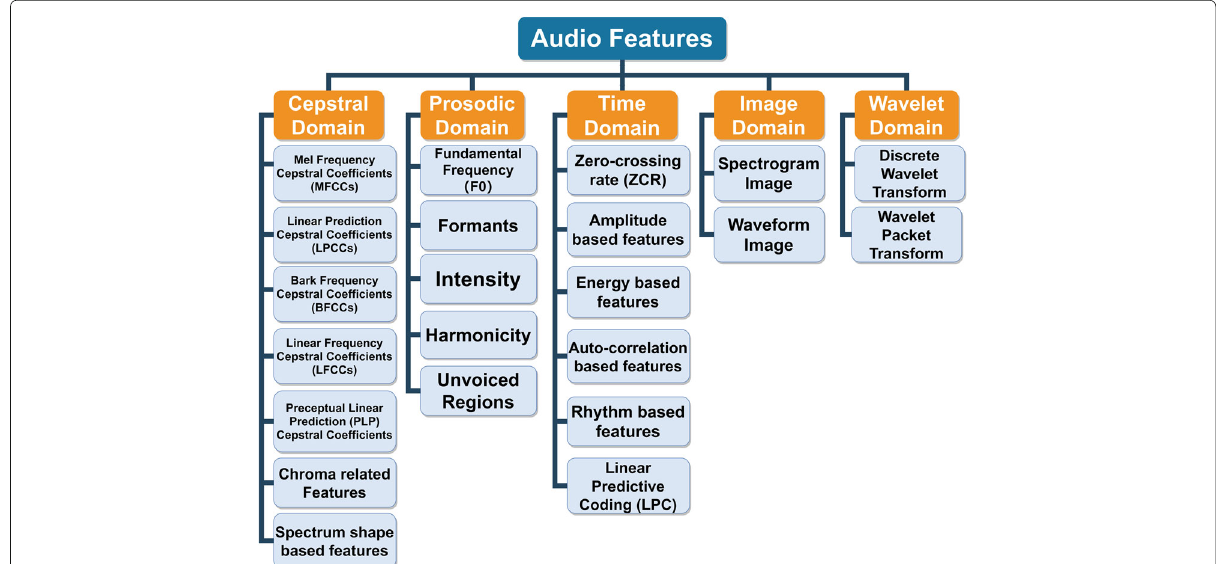
Fig. 3 Main audio feature